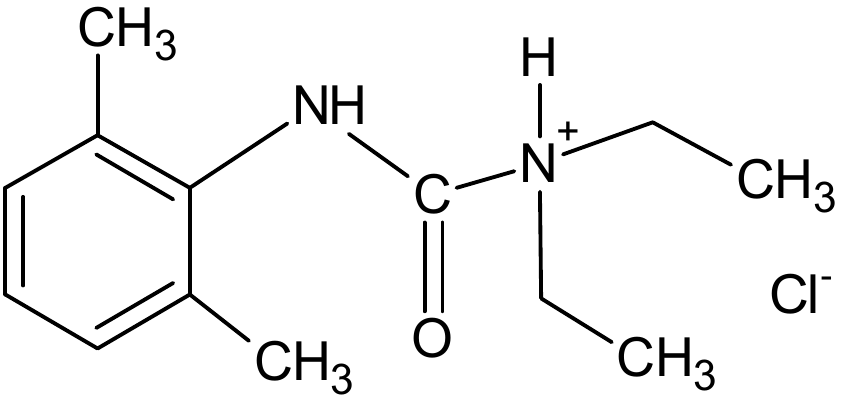
Figure 2. The structure of lidocaine hydrochloride.